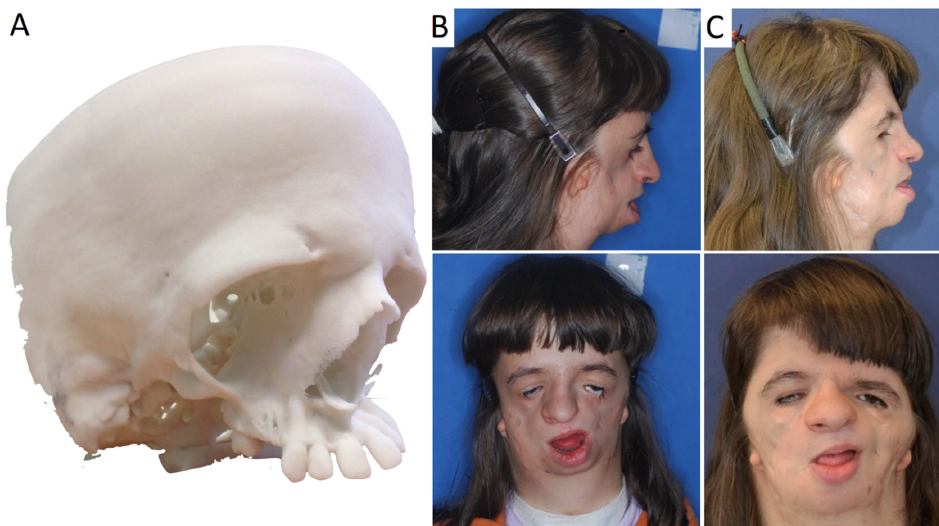
Figure 6. Teenage female patient with TCS. ( A ) Stereolithographic model with visible bone deformations. ( B ) Side and frontal view before major treatment, large deformation of the middle face and mandible resulting in closure of the upper airway, absence of zygomatic bone, coloboma of the lower eyelids. ( C ) Patient after multistage reconstructive treatment forming the shape of face, transplant taken from the cranial vault mounted in place of the zygomatic bone; despite late notification of the therapy, noticeable improvements in facial features.